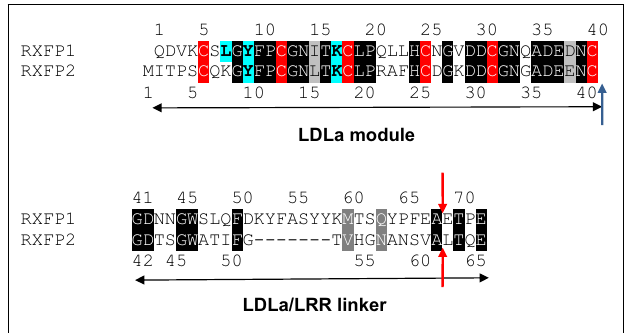
FIGURE 1 |Alignment of the RXFP1 and RXFP2 LDLa module and linker sequences . Identical residues are boxed in black and similar residues are boxed in gray while the conserved cysteine residues are boxed in red. The residues recently identified as being involved in RXFP1 ligand-mediated activation (9) are highlighted in blue in both RXFP1 and where they are conserved in RXFP2. A blue arrow shows where our swapped modules are cleaved. Red arrows show the point of cleavage for the swapped modules in the chimera made by Kern et al.